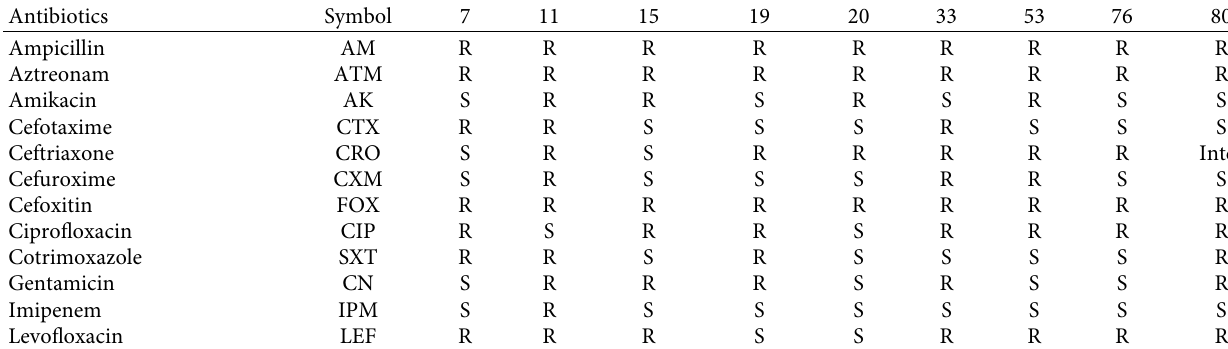
Table 12: Antibiotics resistance and sensitivity